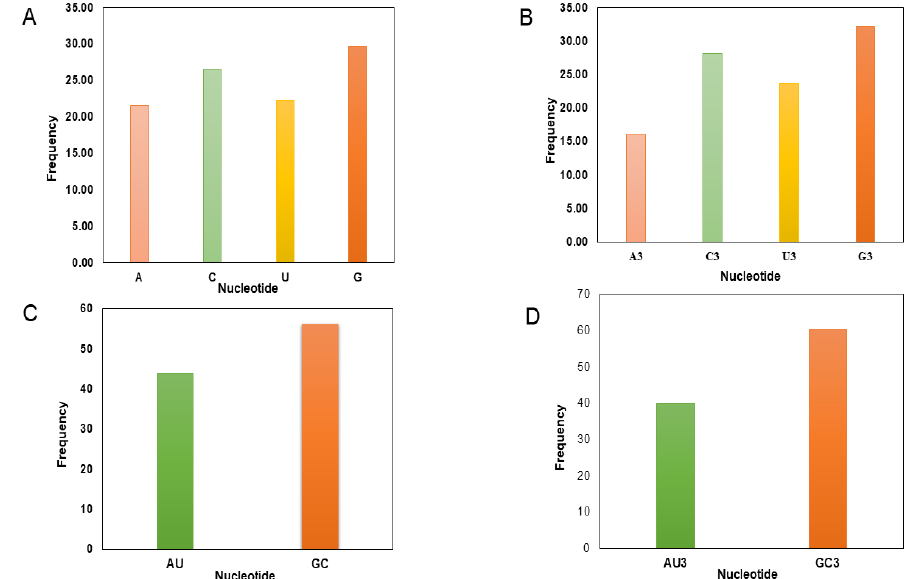
Figure 1. A nucleotide composition analysis: ( A ) The average A, U, G, and C nucleotide composition of the entire viral genome. ( B ) The average values of the nucleotide composition at the third codon position, indicating G/C richness followed A/U richness. ( C ) The mean frequency for GC and AU composition ( D ) The mean frequency of AU and GC at the codon’s third position, indicating that GC3 is more common than AU3. Nucleotide content analysis at the 1st, 2nd, and 3rd synonymous codon positions Table 1. A nucleotide compositional analysis of RYMV coding sequences (%). disclosed that the values of GC1 ranged from 47.45 to 60.28% (mean: 54.88%; SD: 2.76), while GC2 ranged from 46.50 to 61.70% (mean: 52.97%; SD: 3.63). Whereas the GC3 values ranged from 51.52 to 61.70% (mean: 56.44%; SD: 2.97), in contrast, the values of AU3 ranged from 38.40 to 51.72% (mean: 43.56%; SD: 2.97). These data further supported the notion that an extensive area of RYMV is self-possessed of C/G content (Table